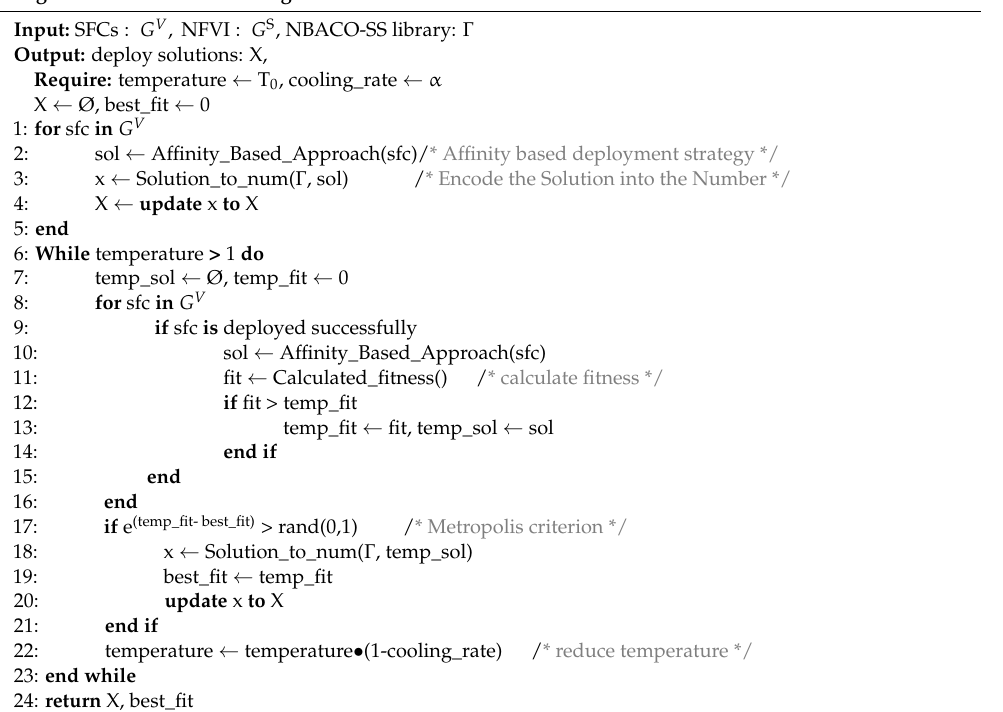
Algorithm 3: NB-SS-ABSA